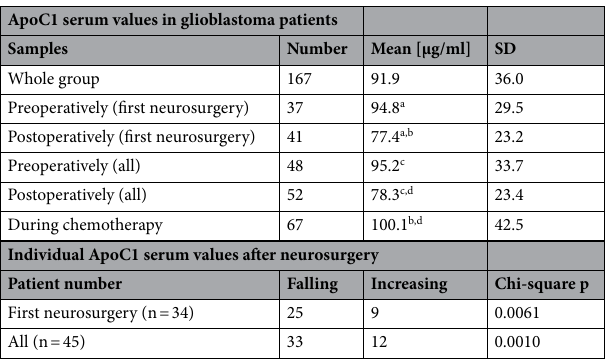
Table 1. Mean ApoC1 levels and changes in individual patients after surgery for glioblastoma. a,b,c,d Values with the same superscript letter differ significantly ( p < 0.05 Mann–Whitney-U test). SD = standard deviation. First neurosurgery = only patients undergoing their first intervention for glioblastoma. All = including patients with first, second or third intervention for glioblastoma.